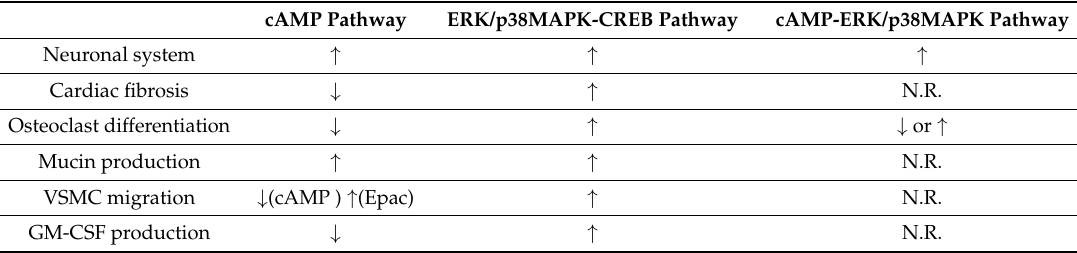
Table 1. Effect of cAMP, ERK/p38 MAPK and cAMP-ERK/p38 MAPK crosstalk pathway on CREB-induced physiological functions. cAMP stimulates both PKA-CREB and Epac pathway. ERK/p38 MAPK pathway phosphorylates CREB and cAMP-ERK/p38 MAPK pathway co-ordinately phosphorylates CREB. ↑ and ↓ means up-regulation and down-regulation of physiological function, respectively. N.R.; not